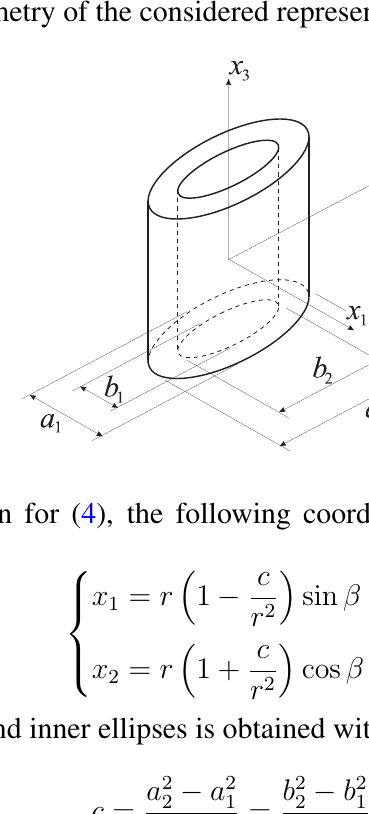
Figure 1 . Geometry of the considered representative volume